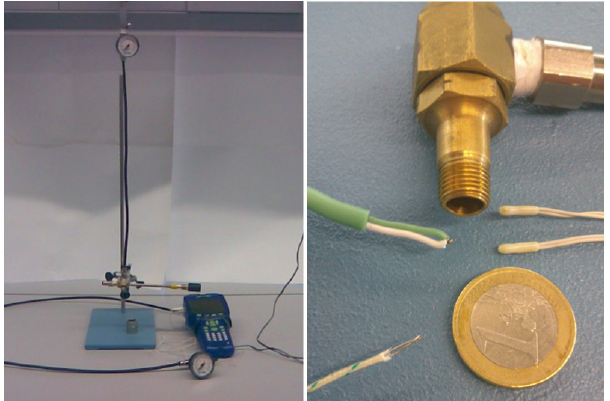
Figure 1. A general view of the laboratory equipment and details of the K-class thermocouples